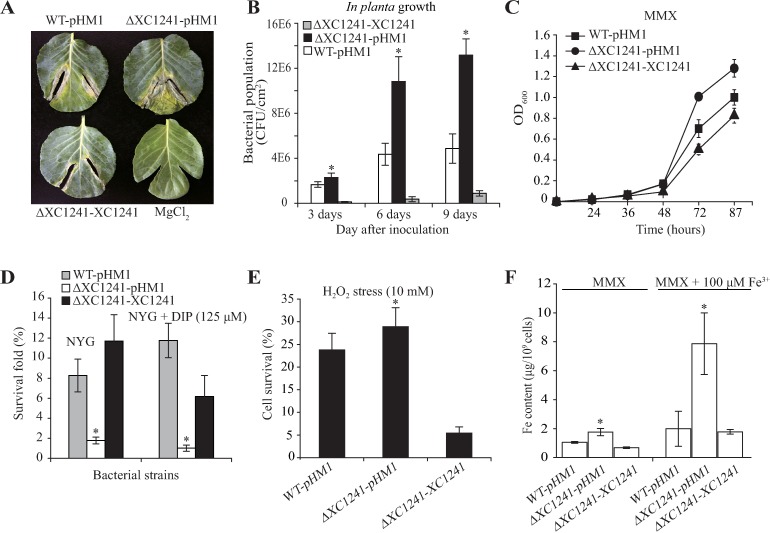
XC1241 (tdvA) expression is detrimental to bacterial virulence and iron uptake under iron-depleted condition.(A) Inactivation of tdvA increased bacterial virulence against host cabbage (B. oleraceae). Virulence levels were recorded 8 days after inoculation. Inoculation of 1 mM MgCl2 was used as a negative control. (B) Bacterial population grown in planta. Bacterial strains were injected into plant leaves using a 1 ml syringe. Bacterial colonies were isolated from leaf disks and counted by serial dilution after inoculation. Each value is the average number calculated from six leaf disks. (C) Bacterial growth curves in iron-depleted MMX medium. Vertical bar indicates the standard deviation (n = 3). (D) Survival of bacterial strains subjected to streptonigrin treatment. Bacterial cultures (OD600 = 0.4) in NYG media were treated with streptonigrin (SNG, 1 μg/ml) for 16 h and the survival rates were calculated by counting the cells before and after stress. 2, 2′-dipyridyl (DIP) (125 μM) was added into the NYG medium to chelate free iron ions. Vertical bars represent the standard deviations (n = 3). (E) Survival rate of bacterial strains treated by H2O2 stress. Bacterial cultures (OD600 = 0.6) in NYG media were treated with H2O2 (10 mM) for 15 minutes and survival rates were calculated by counting the cells before and after stress. Vertical bars represent the standard deviations (n = 3). (F) Iron concentration in bacterial cells. Equal volumes of bacterial cells were cultured in minimal medium MMX or MMX plus 100 μM Fe3+. The amounts of total iron in the cells were measured using inductively coupled plasma spectroscopy (ICP-OES). Vertical bars represent the standard deviations (n = 3). In (B, D, E, and F), * indicates a significant difference (by Student’s t-test, P < 0.05) compared with the wild-type (WT) strain under the same test conditions.